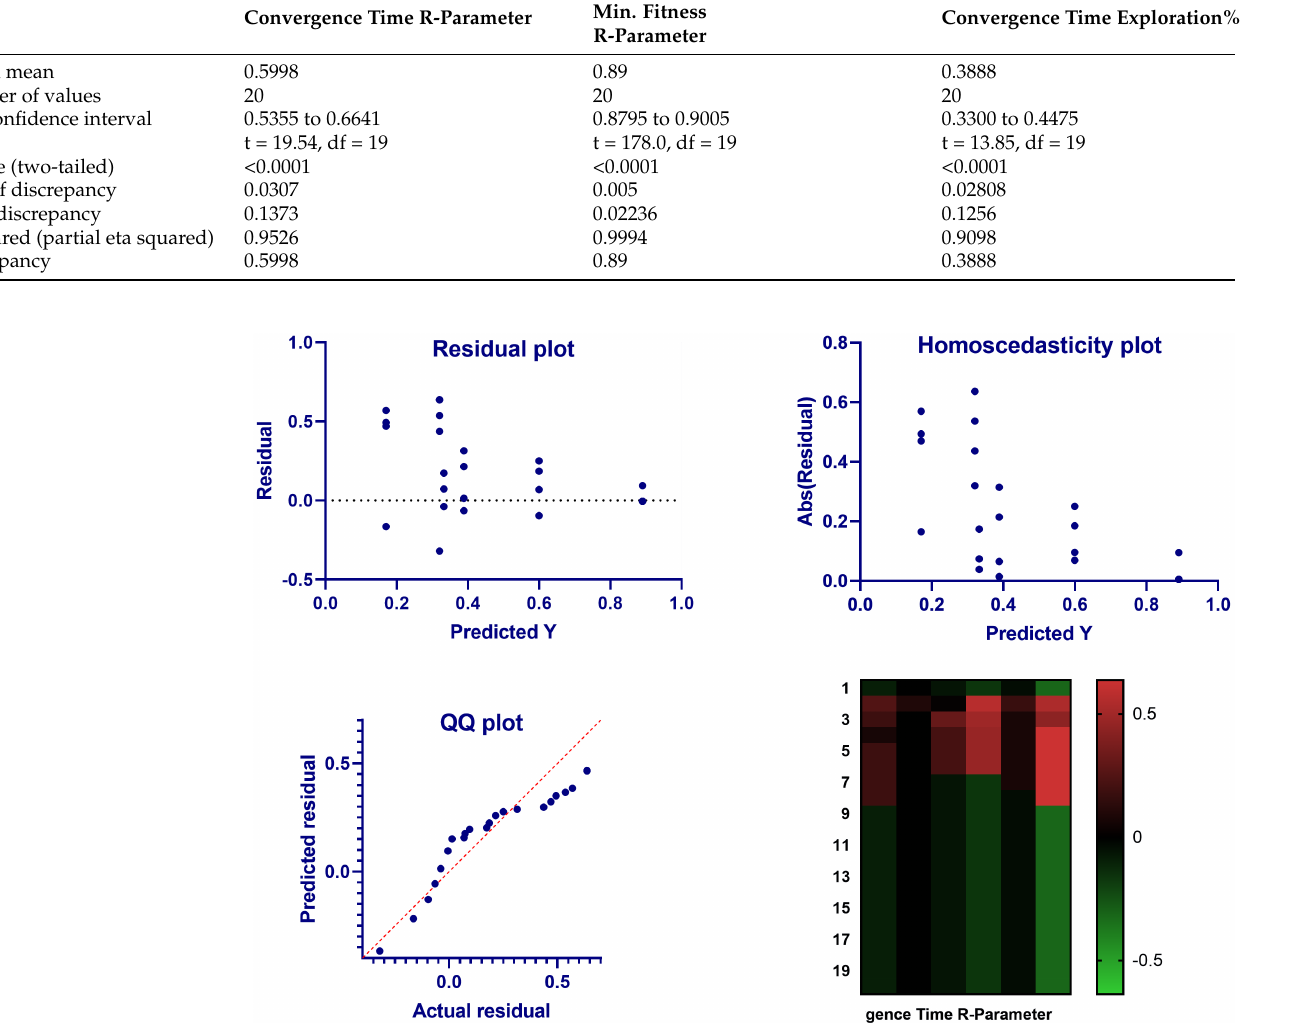
Table 13. Statistical analysis of the results achieved by sensitivity analysis of DTO parameters, part 2.